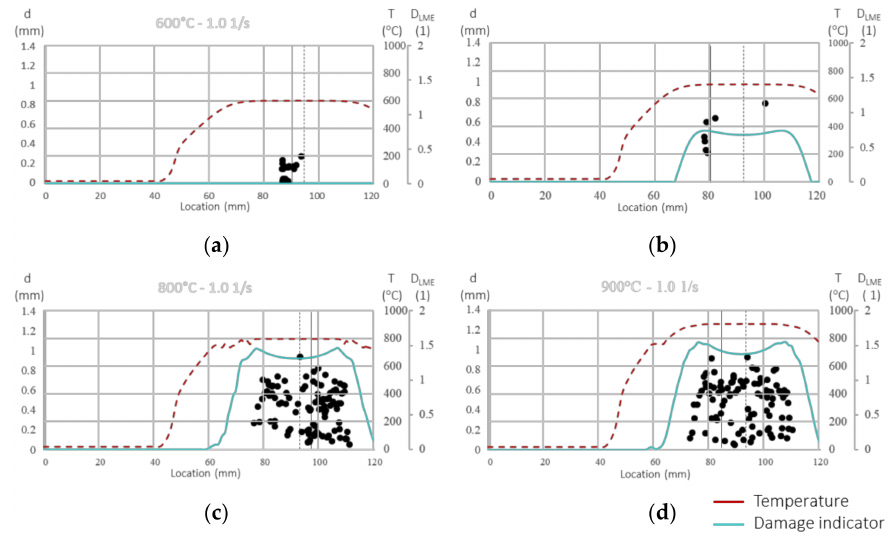
Figure 10. Comparison of the calculated temperature distribution T (red and dashed) and the damage indicator D (cyan) with the crack depth d measured in the samples (the path is shown in Figure 1 marked with s) in mm (black dots) and the sample center (dotted vertical line) as well as the rupture location (solid vertical line) for a strain rate of 1.0 s − 1 at ( a ) 600 ◦ C; ( b ) 700 ◦ C; ( c ) 800 ◦ C and ( d ) 900 ◦ C.